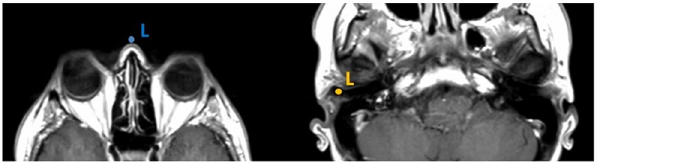
Fig 11. Left , blue Landmark L , nasion : The slice that contains the center of both eyeballs, shown by presence of the lenses. Right , yellow landmark L , porus : The slice containing the outer part of the external auditory canal is chosen and the point is placed medial to the tragus. This is the position where the blunt leg of the caliper will come to rest.